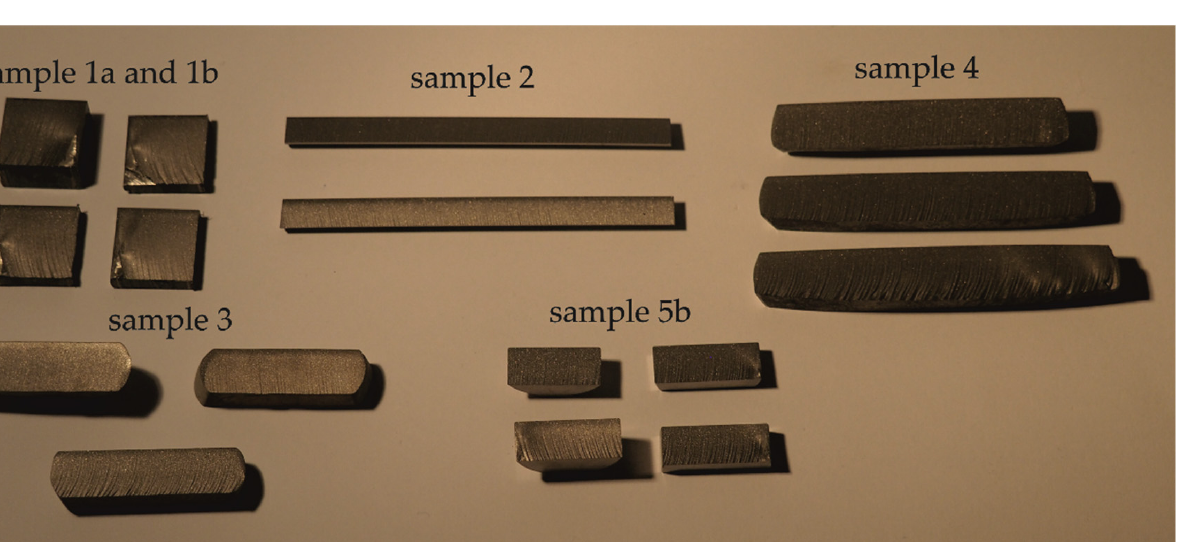
Table 1. Setup of basic experimental variables of AWJ (fixed variables).